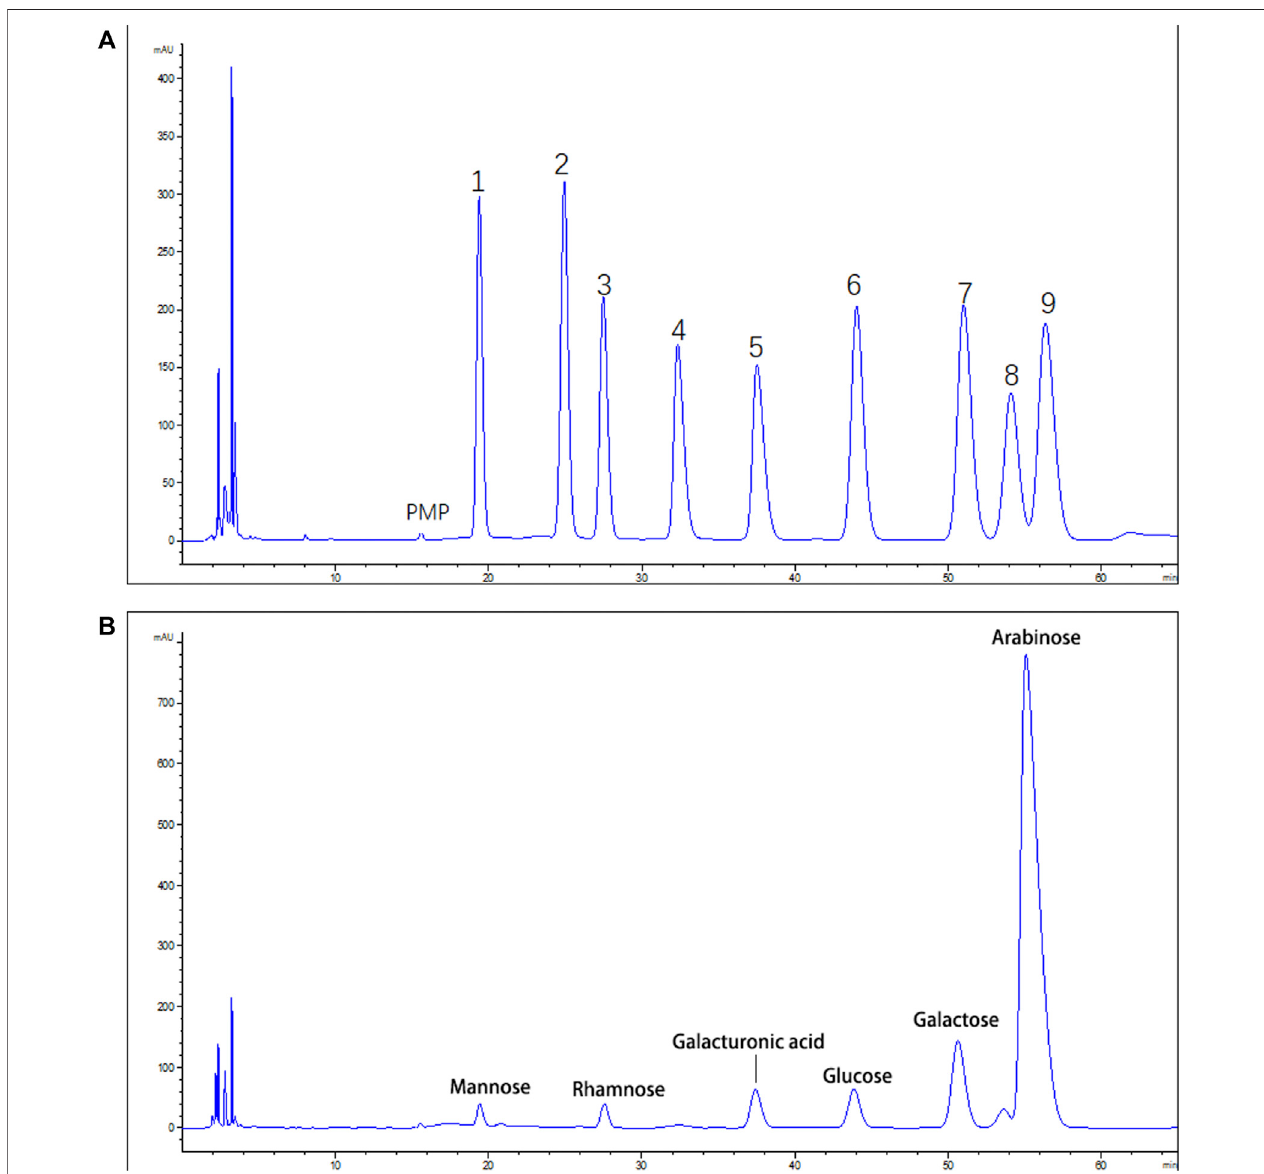
FIGURE 2 | HPLC analysis of CSP (A) . Standard monosaccharide mixture. 1: Mannose; 2: ribose; 3: rhamnose; 4: Glucuronic acid; 5: galacturonic acid; 6: glucose; 7: galactose; 8: xylose; 9: arabinose (B) . The monosaccharide compositions of CSP.